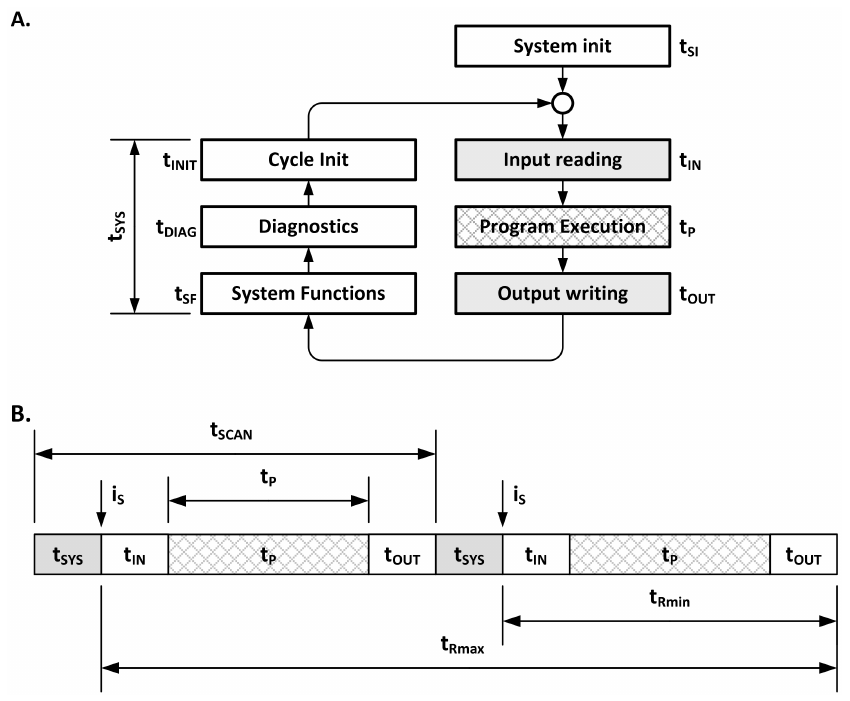
Figure 1. The PLC operation diagram ( A ) and response time analysis ( B